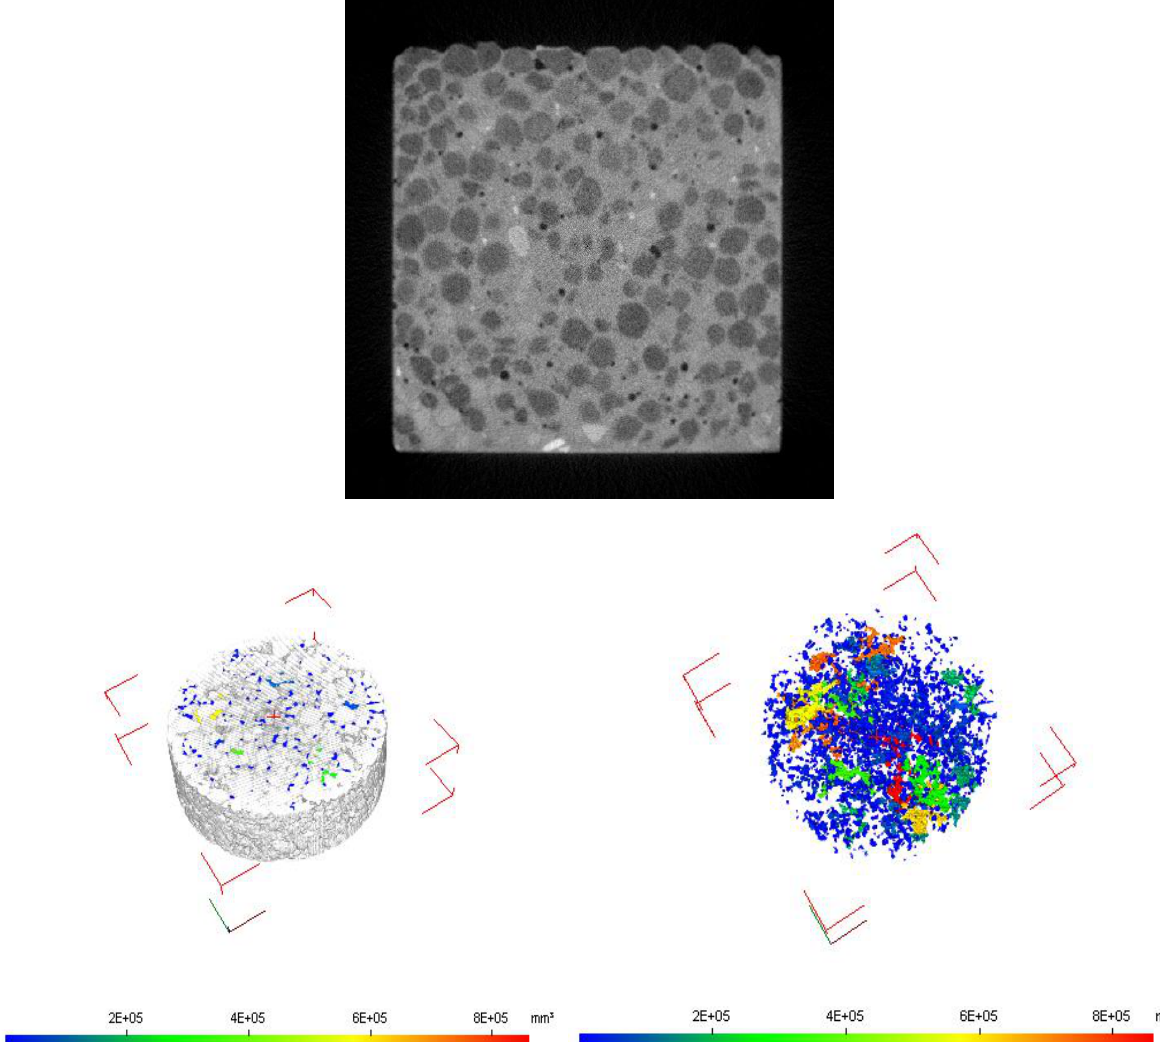
Figure 8. 3D X-ray micro-tomography views of the nano-silica